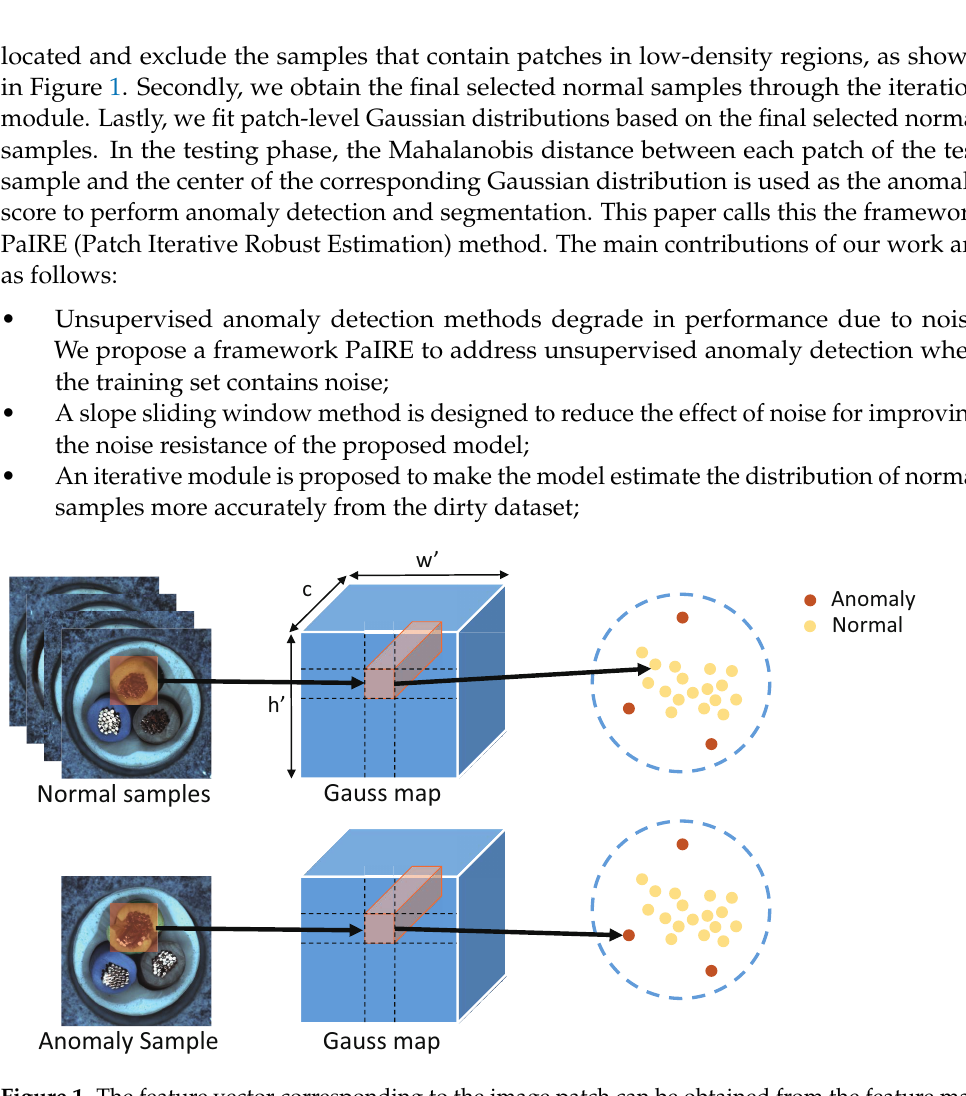
Figure 1. The feature vector corresponding to the image patch can be obtained from the feature map extracted from the pre-trained network. In the feature space, the normal patches are in the high- density region and the anomaly patches are in the low-density